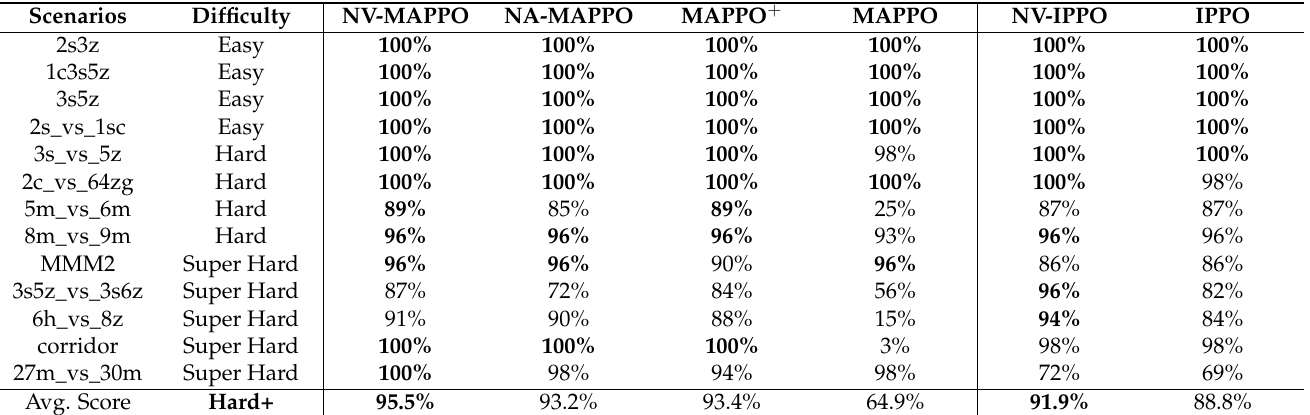
Figure 5. The training curves of MAPG and MAPPO, and their noisy variants in some Hard and Super-Hard testing scenarios in SMAC. Table 3. Median test win rates of MARL algorithms in scenarios of SMAC. MAPPO + represents the MAPPO with agent-specific features, and Hard+ includes Hard and Super-Hard